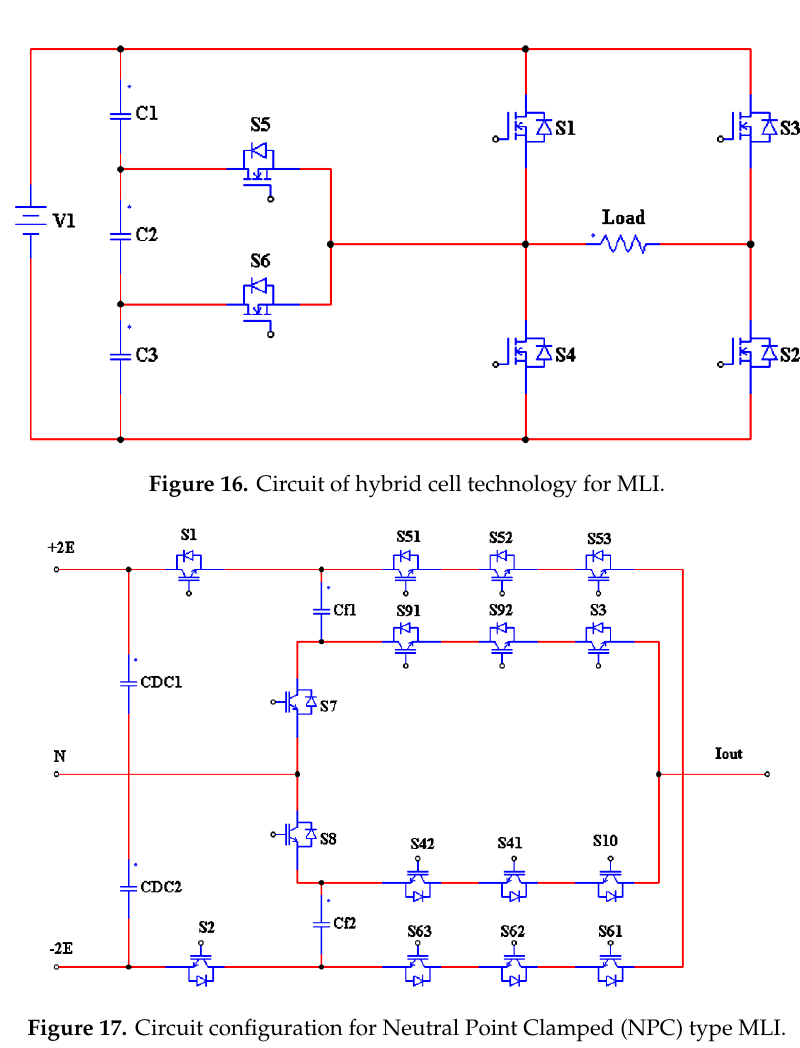
Figure 17. Circuit configuration for Neutral Point Clamped (NPC) type MLI.